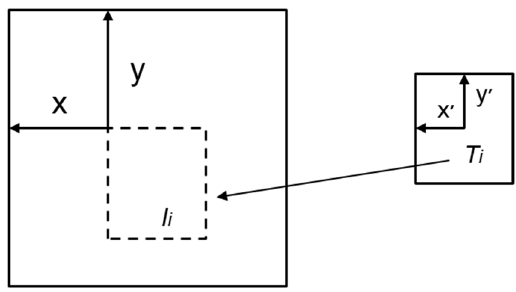
Figure 15. Schematic diagram of template matching.